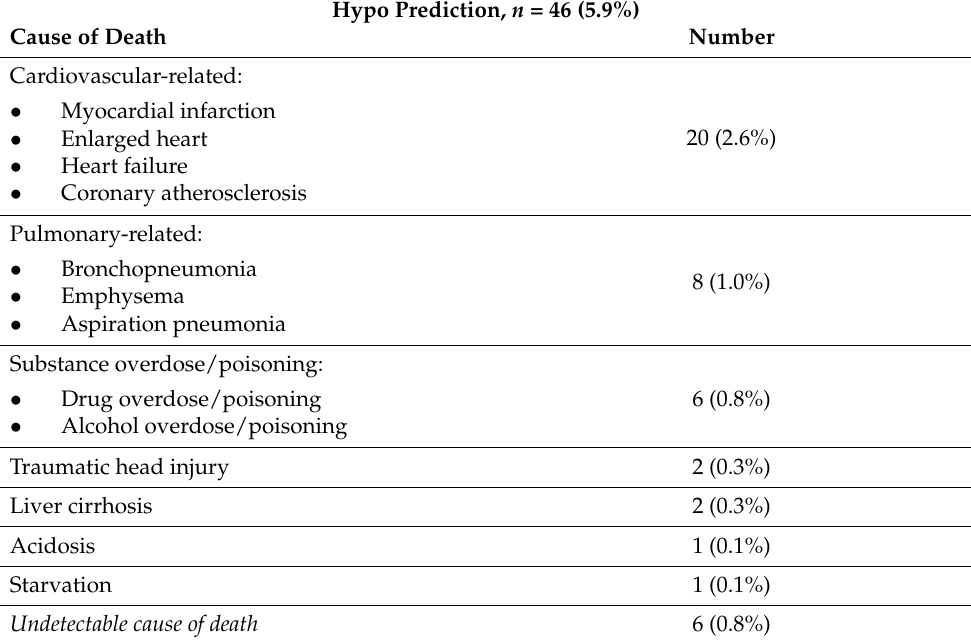
Table 4. Reported causes of death for the test group cases that were screened as possible hypogly- cemia-related deaths, using a class prediction model based on the insulin intoxication metabolic fingerprint.